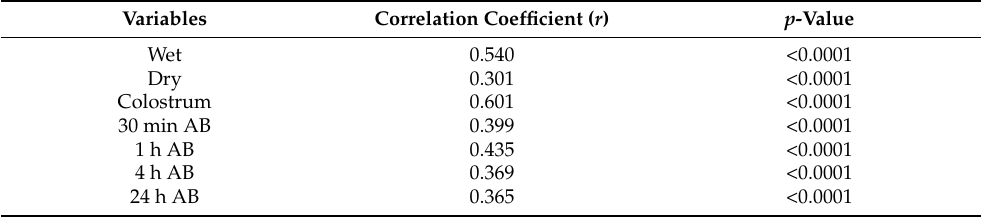
Table 9. Significant correlations between the thoracic limb brachial biceps (TLBB) temperatures of newborn puppies and the weight of the dams at different times: wet (with amniotic fluid), dry (once the puppy was rubbered), colostrum (after colostrum intake and separated from mother’s teat), 30 min AB, 1 h AB, 4 h AB, and 24 h AB.